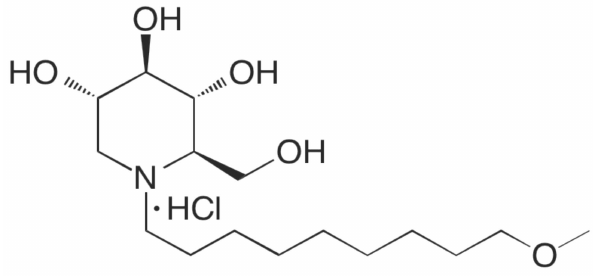
Figure 1. Structure of the iminosugar